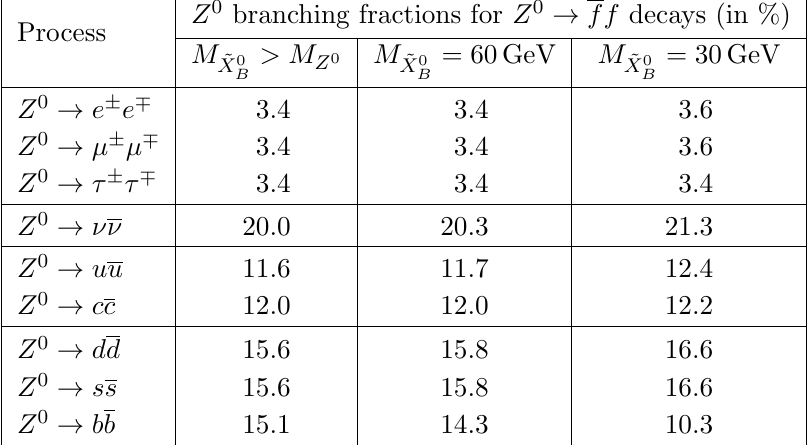
> M ) are taken Z 0 X 0 B